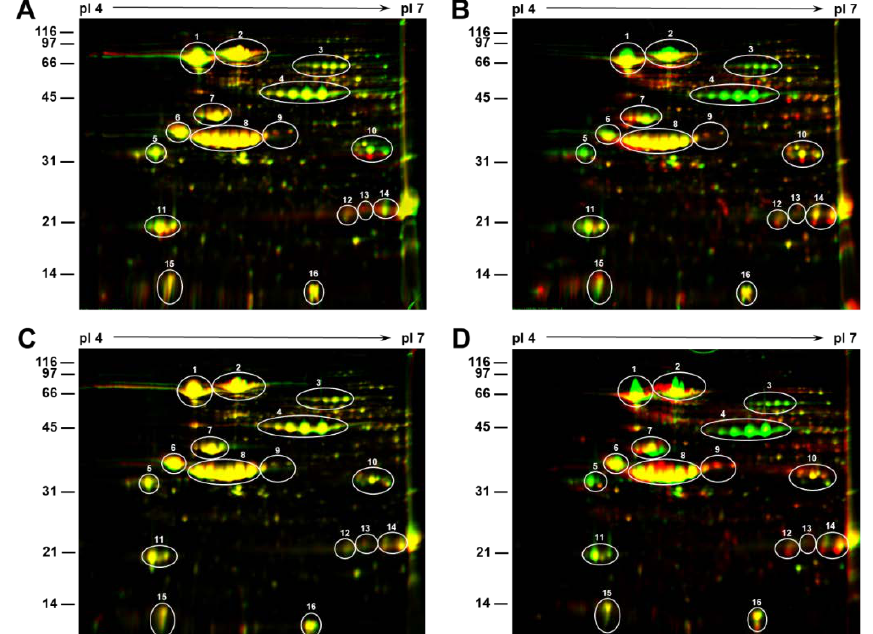
Figure 2. Effect of growing temperature on the seed proteins isolated from tolerant (TG) and heat stress sensitive (SG) genotypes. Seed proteins (300 μg) were first separated by isoelectric focusing on pH 4−7 strips followed by separation by SDS -PAGE on 16% gels. The gels were stained with colloidal Coomassie blue G-250. Gels were scanned and the resulting images were assigned two different colors (green = 28/22 °C and red = 36/24 °C and 42/26 °C), in order to visualize the differences between the two. For observing heat stress induced protein changes two identically separated 2D gels of soybean seed proteins grown at different temperatures were overlaid using Delta2D software. ( A ) Overlay between SG grown at 28/22 °C and 36/24 °C; ( B ) overlay between SG grown at 28/22 °C and 42/26 °C; ( C ) overlay between TG grown at 28/22 °C and 36/24 °C; and ( D ) overlay between TG grown at 28/22 °C and 42/26 °C. The superimposed color images generated by Delta2D software facilitates the identification of differences between the two treatments where yellow demonstrates similar protein quantities in both growing temperatures. The green color demonstrates absence of that particular protein species in the seeds grown at higher temperature and the presence of the red color demonstrates the accumulation of that particular protein species in the seeds grown at higher temperature. Spots 1, 2, and 4 represent the 7S -conglycinin subunits and spots 6–10, 12–14, and 16 represents the different glycinin subunits. Spots 3, 5, 11, and 15 are the sucrose binding proteins, p34 thiol protease, the Kunitz trypsin inhibitor (KTI) and the Bowman-Birk inhibitor (BBI), respectively.